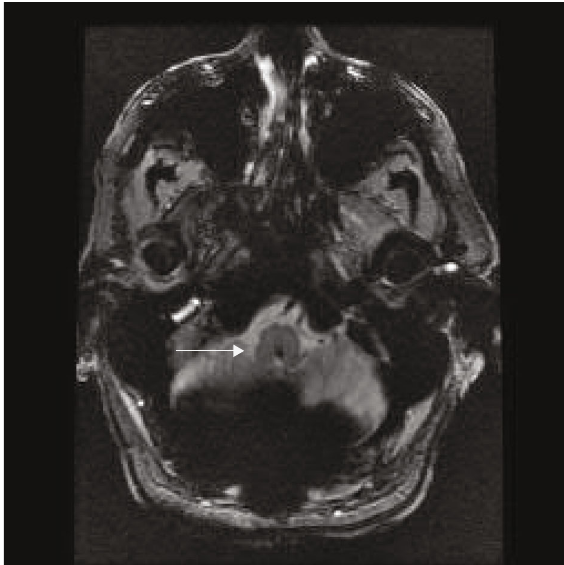
Figure 7: Postoperative cervical T2-weighted axial image demonstrates resolution of the caudal medullary